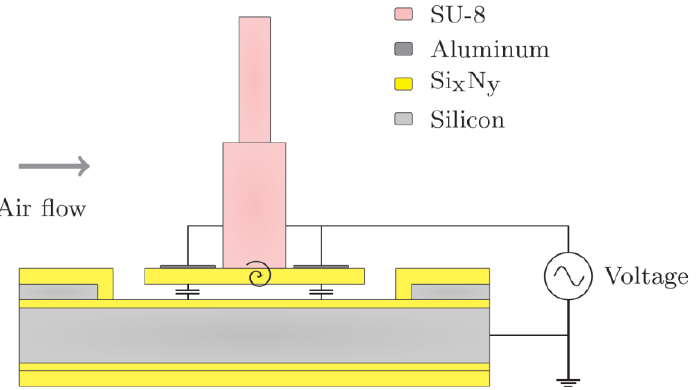
Figure 3. Stiffness control by applying bias voltages to the sensor’s